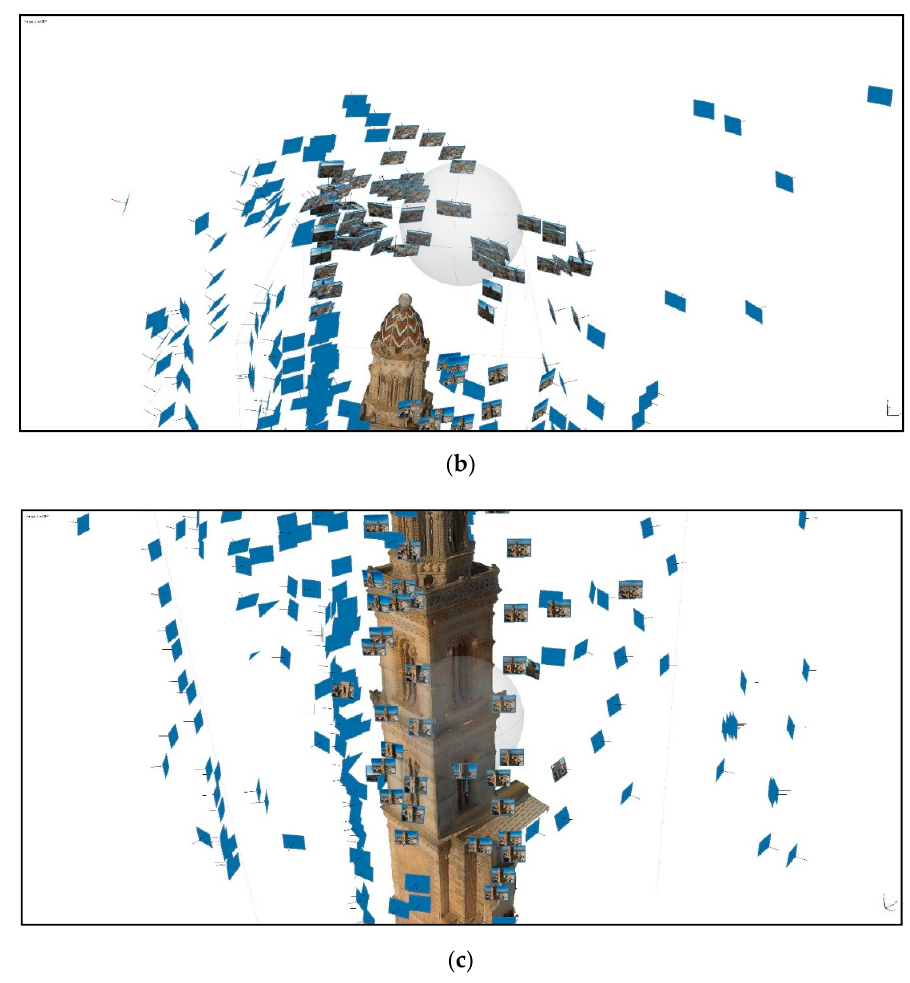
Figure 4. Drone catches of the bell tower: ( a ) global view; ( b ) dome and ( c ) main body.